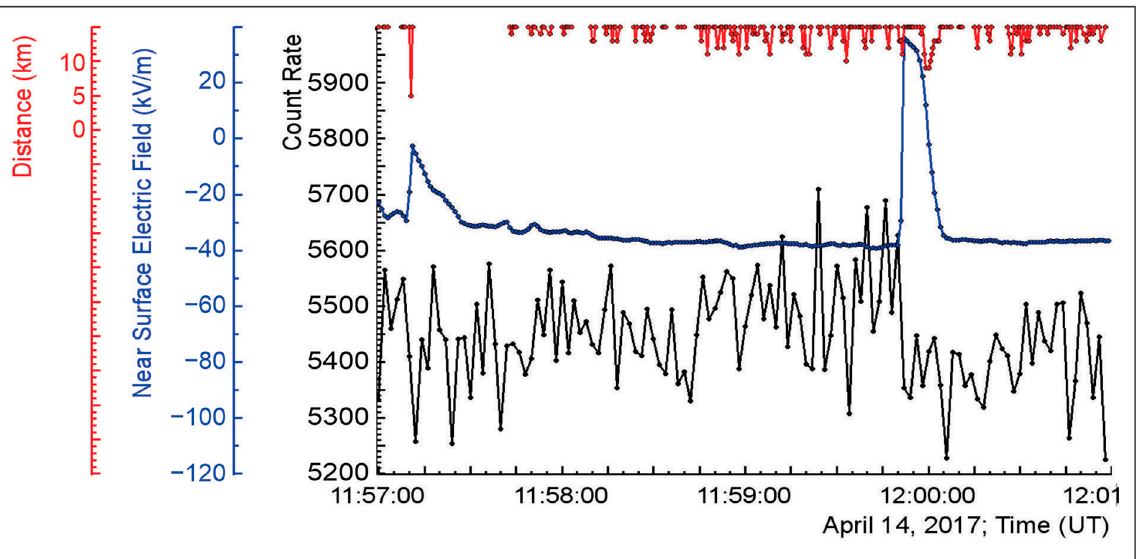
Figure 13. TGE abruptly interrupted by a lightning flash at 11:59:51.82; triggers were registered in the MAKET and SKL halls at 11:59:51.75; a surge of the NSEF started at 11:59:51.94; the decline of particle flux started at 11:59:51.83 .